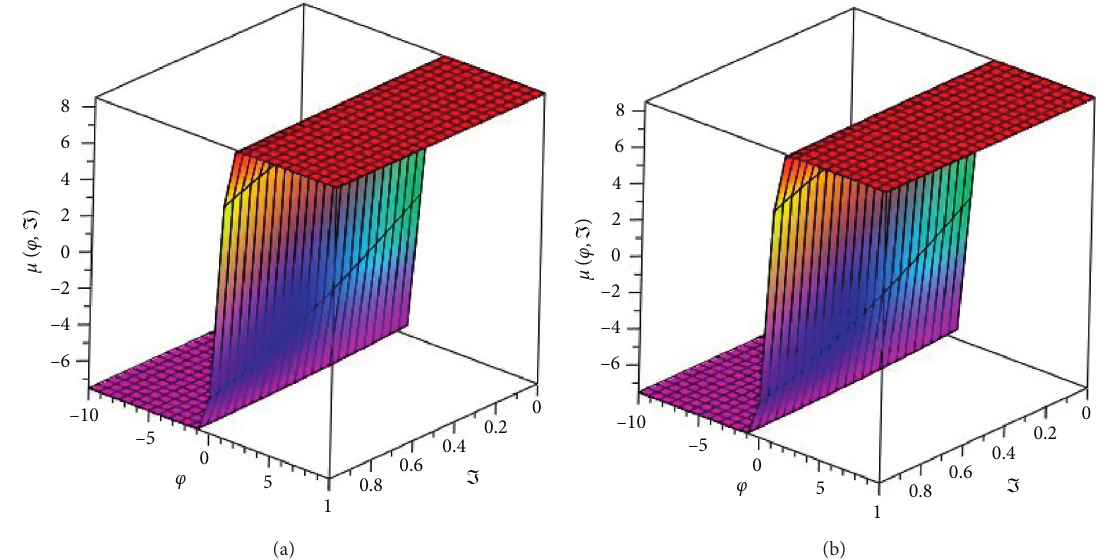
Figure 1: The exact and analytical solution with respect to the Caputo–Fabrizio operator of μ ( φ , I ) at β � 1 of Example 1.